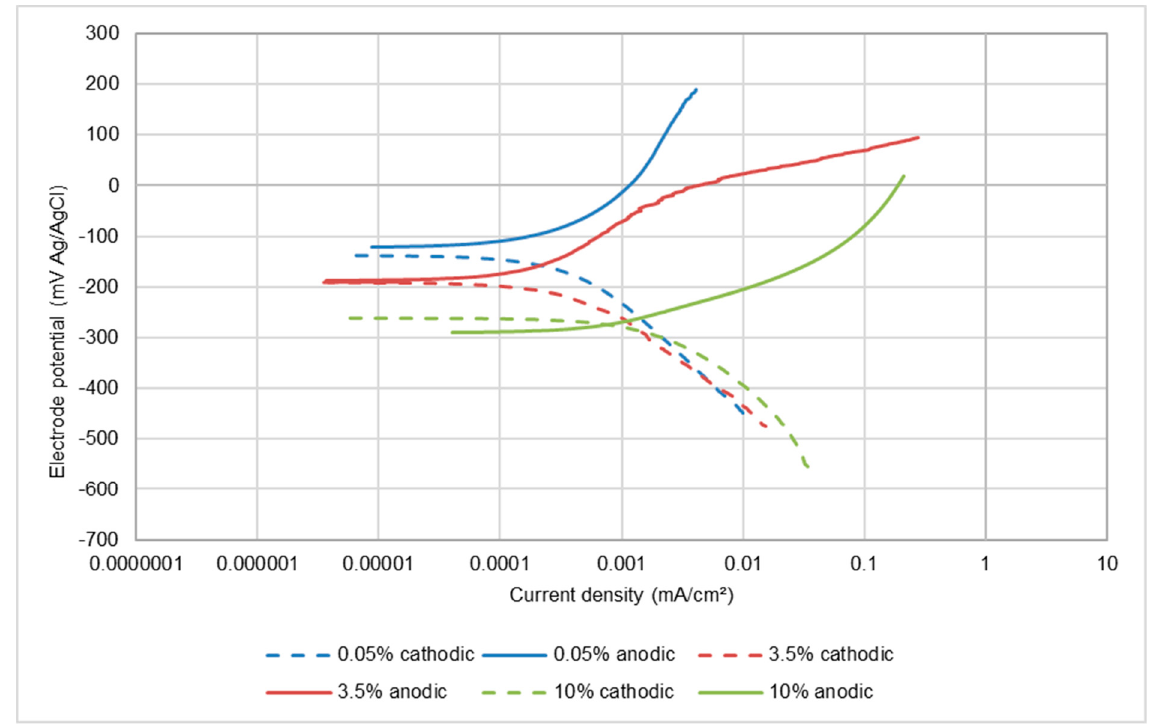
Figure 5. Polarisation plots for UNS S31600 in static conditions.